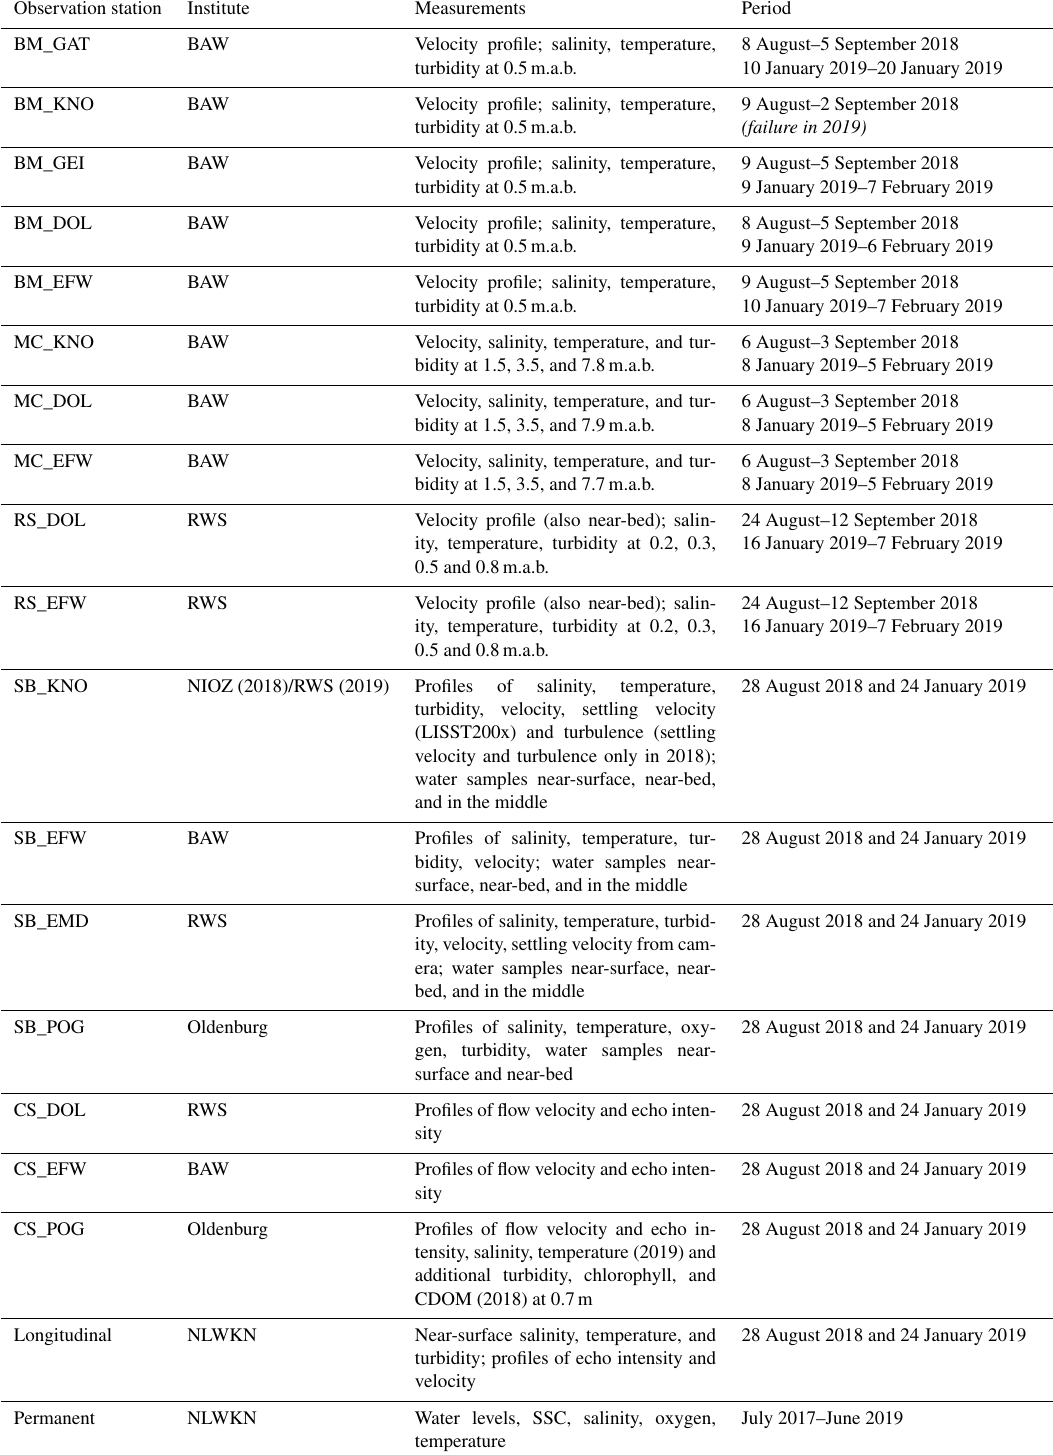
Table 2. Summary of executed measurements per location: name of observation station, institute in charge of survey vessel, executed measurements, and measurement period. The measurements executed at Pogum (CS_POG and SB_POG, both in italics) suffered from high SSC values, corrupting the OBS and ADCP data. The OBS and ADCP data should be processed and interpreted carefully, and therefore only water samples, temperature, and salinity profile results are presented as part of this dataset. Observation station BM_KNO suffered from mechanical failure in 2019, and BM_GAT measured for only 10d in